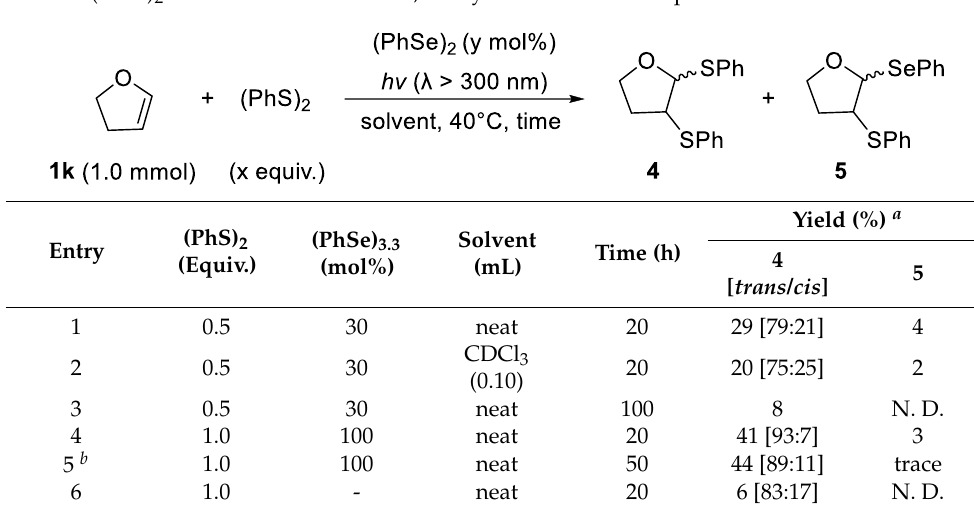
Table 1. (PhSe) 2 -assisted dithiolation of 2,3-dihydrofuran 1k under photoirradiation.